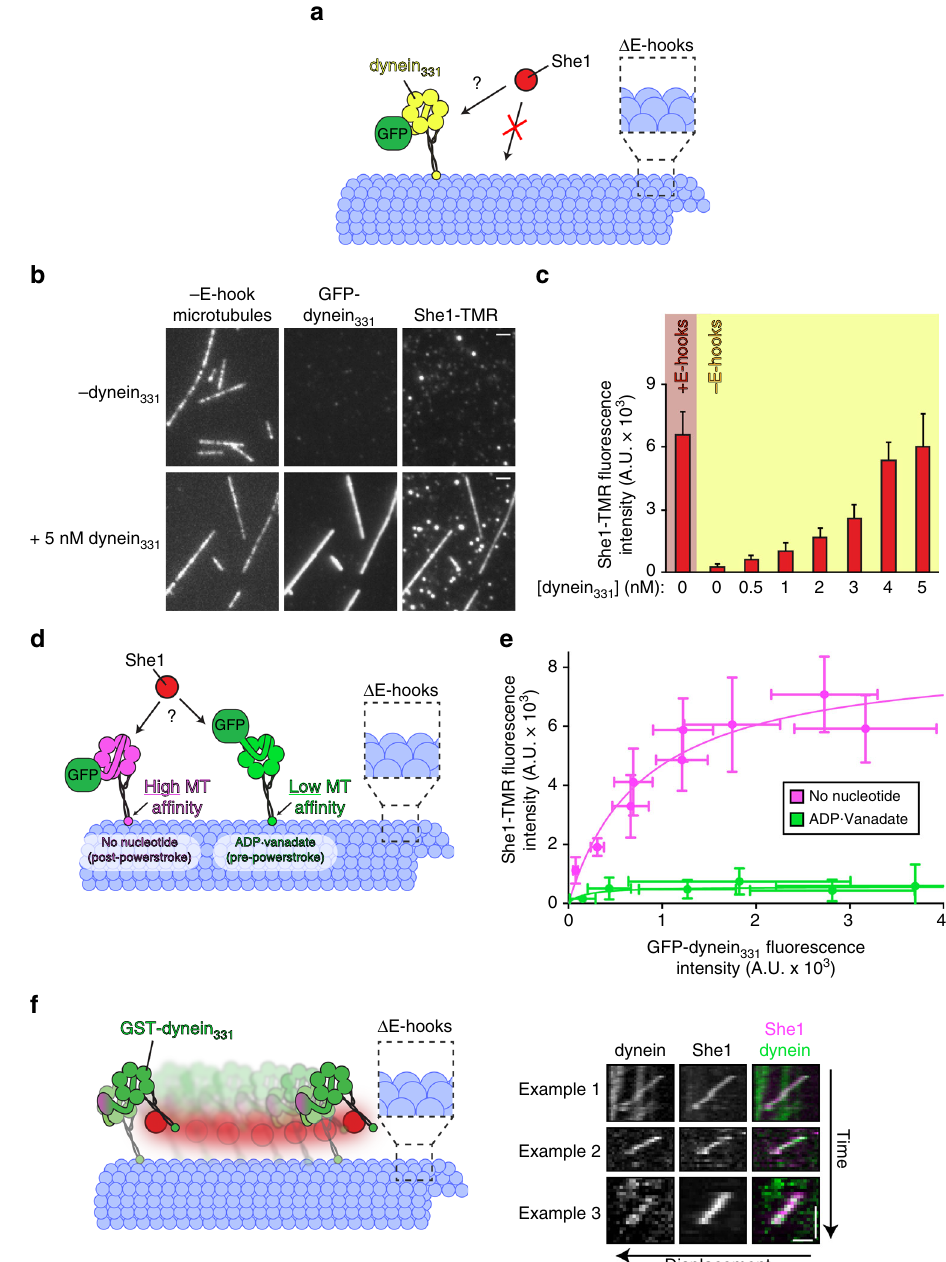
Fig. 4 She1 binds directly to dynein, and recognizes a speci fi c nucleotide-bound state. a Schematic of experimental setup. Note that for these experiments, a GFP-tagged monomeric dynein 331 (GFP – dynein 331 ) fragment was used. b – d Representative fl uorescence images ( b ) and quantitation ( c ) of She1-TMR recruitment ( fi xed at 40 nM) to control ( “ +E-Hook ” ) or subtilisin-digested ( “ − E-hook ” ) microtubules by increasing concentrations of GFP – dynein 331 (scale bars, 2 µ m; error bars, standard deviation; n ≥ 19 microtubules, and ≥ 75 µ m of MT length for each condition). d Schematic of experimental setup. Note that the absence of nucleotide elicits a conformational state that is distinct from that of dynein in the presence of ATP and vanadate (see text). e Relative recruitment of She1-TMR by GFP – dynein 331 in the presence of either no nucleotide (apo) or 3 mM ATP and vanadate (ADP – vanadate). Different points re fl ect the mean fl uorescence intensity values (along with standard deviations) of She1-TMR ( fi xed at 40 nM) vs. increasing concentrations of GFP – dynein 331 . Given the different microtubule-binding af fi nity of GFP – dynein 331 in each nucleotide state (Supplementary Fig. 3a), the extent of She1-TMR microtubule recruitment was directly compared to the relative microtubule binding by GFP – dynein 331 ( n ≥ 10 microtubules, and ≥ 36 µ m of MT length for each condition). f Cartoon (left) and three example kymographs (right) depicting that on subtilisin-digested microtubules, She1 remains bound